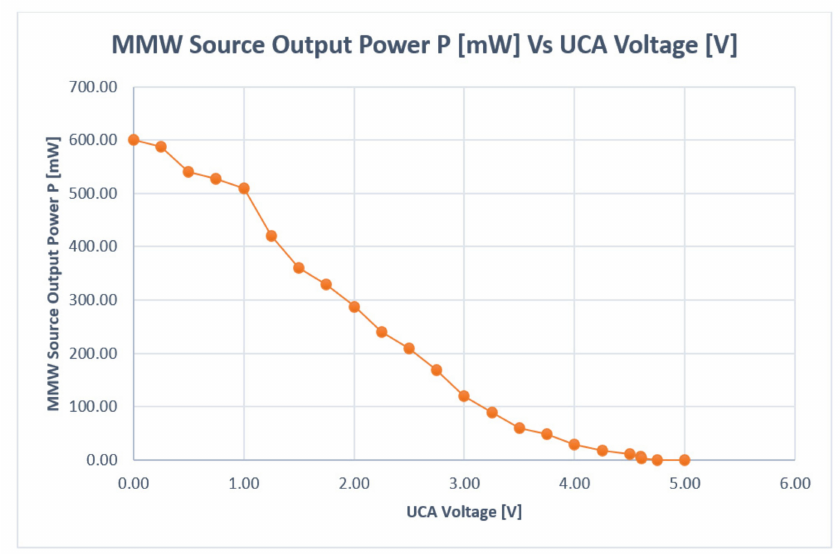
Figure 5. Variation in MMW source power according to the UCA